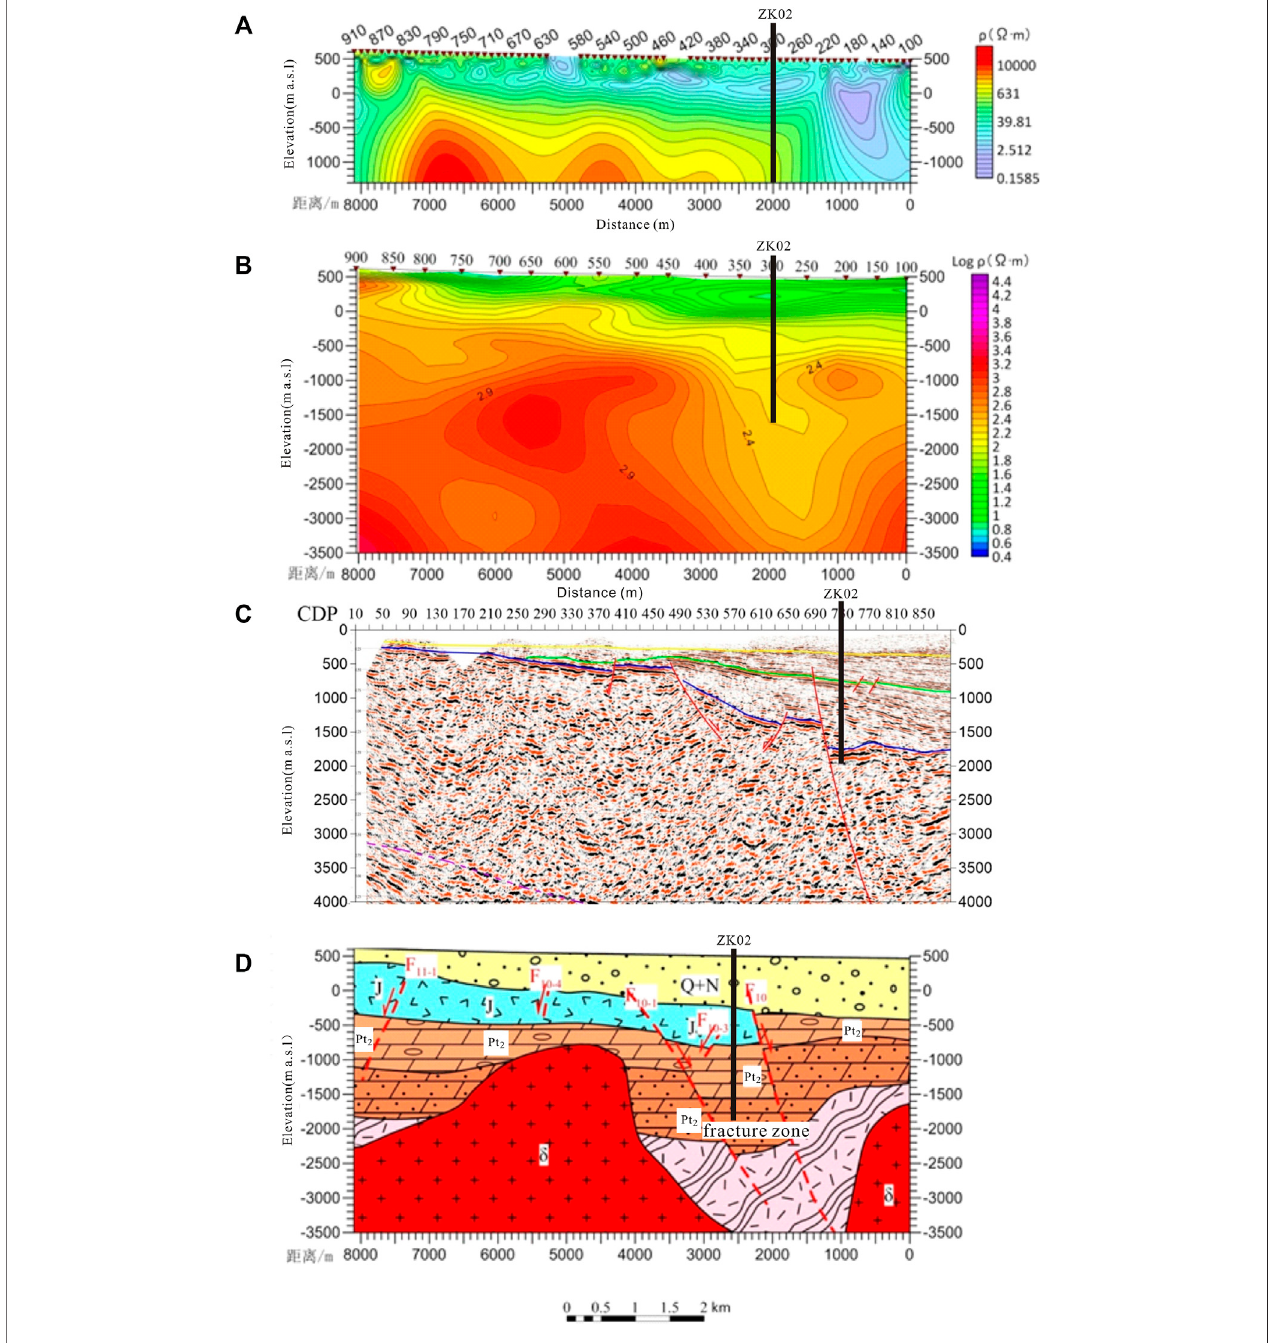
FIGURE 9 | Interpreted geologic pro fi le of target Well ZK02. (A) Resistance inversion pro fi le of C 5 survey line (refer to Figure 1 for the location). (B) Resistance inversion pro fi le of M 5 survey line (refer to Figure 1 for the location). (C) Depth converted 2D seismic section of D 4 survey line (refer to Figure 1 for the location). (D) Geologic interpretation